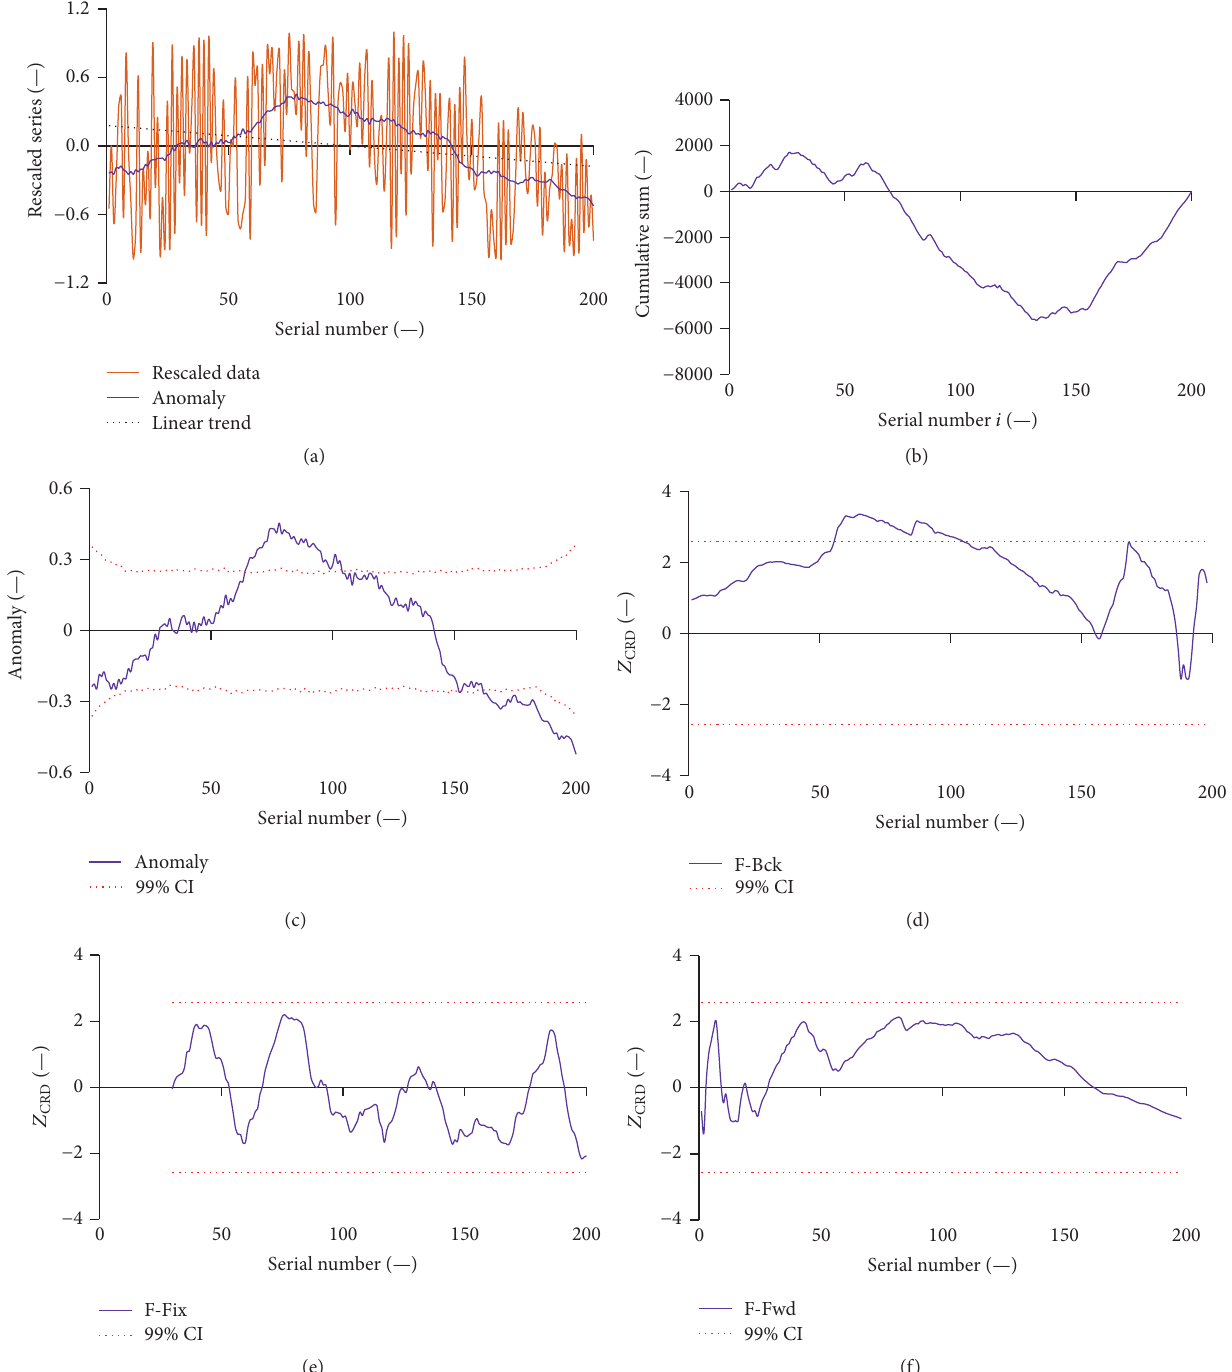
Figure8:CRD-basedtrenddiagnosesinterms(a)RSP,(b)CRDplot,(c)NAP,andTEPsbased(d)F-Bck,(e)F-Fix,and(f)F-Fwdapproaches.